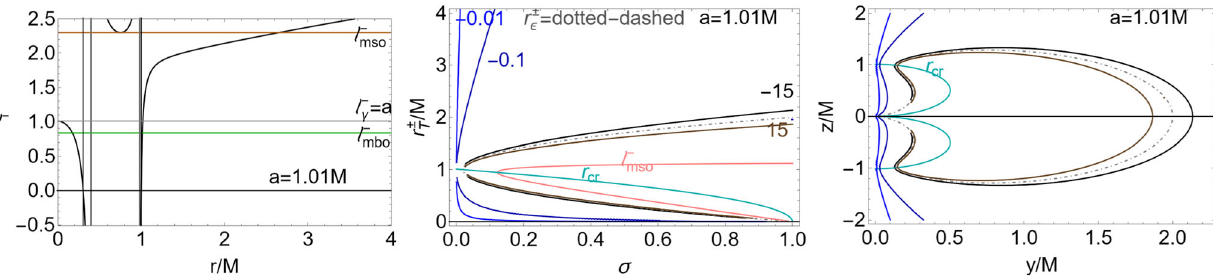
cles with ( E < 0 , L < 0 ) in the conditions of Sec. (C). Radius r ± (cid:11) is the outer and inner ergosurfaces, and r cr is defined in Eq. (10). Nota- . 0 tion ( mbo ) is for marginally bounded orbit, ( mso ) for marginally stable orbit. Momentum (cid:6) − γ = a refers on the limiting value of the specific angular momentum (cid:6) = (cid:6) − > 0 for the occurrence of proto-jets (sim- (cid:6) z 2 + y 2 and σ = y 2 /( z 2 + y 2 ) . ilarly to the (cid:6) + case). There is r = The inversion sphere always closes on the equatorial plane, for small in magnitude (cid:6) closes at large r